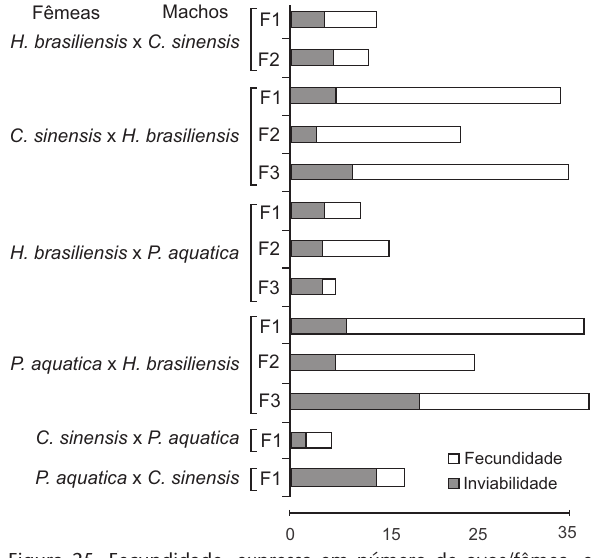
Figura 25. Fecundidade, expressa em número de ovos/fêmea, e inviabilidade na fase de ovo nos intercruzamento de indivíduos de E. banksi oriundos de três hospedeiros (usando-se como substrato folhas do hospedeiro da fêmea) por três gerações consecutivas (BOD a 28 ± 1°C e 12 horas de fotofase; 70 ± 10%